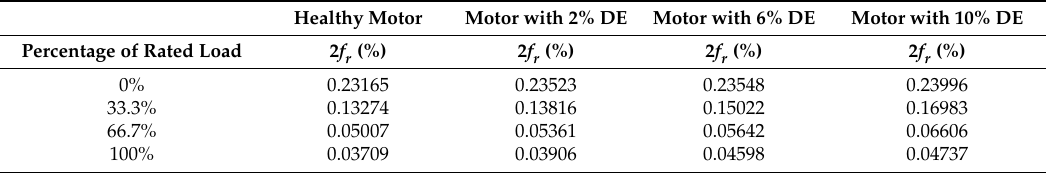
Table 2. The amplitudes of FSF at a frequency of 2 f r for the healthy and faulty motors from no load to full